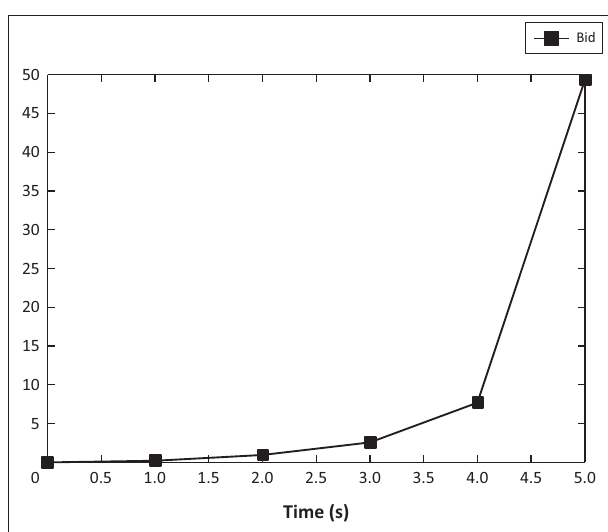
FIGURE 5: Plot of B